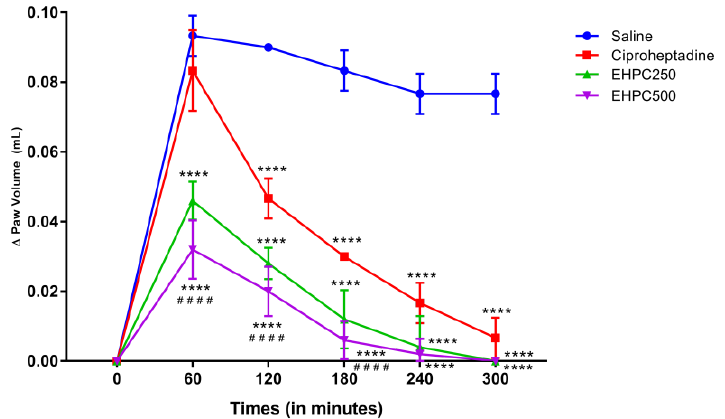
Figure 3. Dextran–Induced Paw Edema induced by subplantar administration of 1% dextran in mice treated orally with 0.9% NaCl, ciproheptadine 10 mg / kg, EHP 250 mg / kg and EHP500 mg / kg. **** p < 0.0001 vs. CTRL; #### p < 0.0001 vs. ciproheptadine (ANOVA;